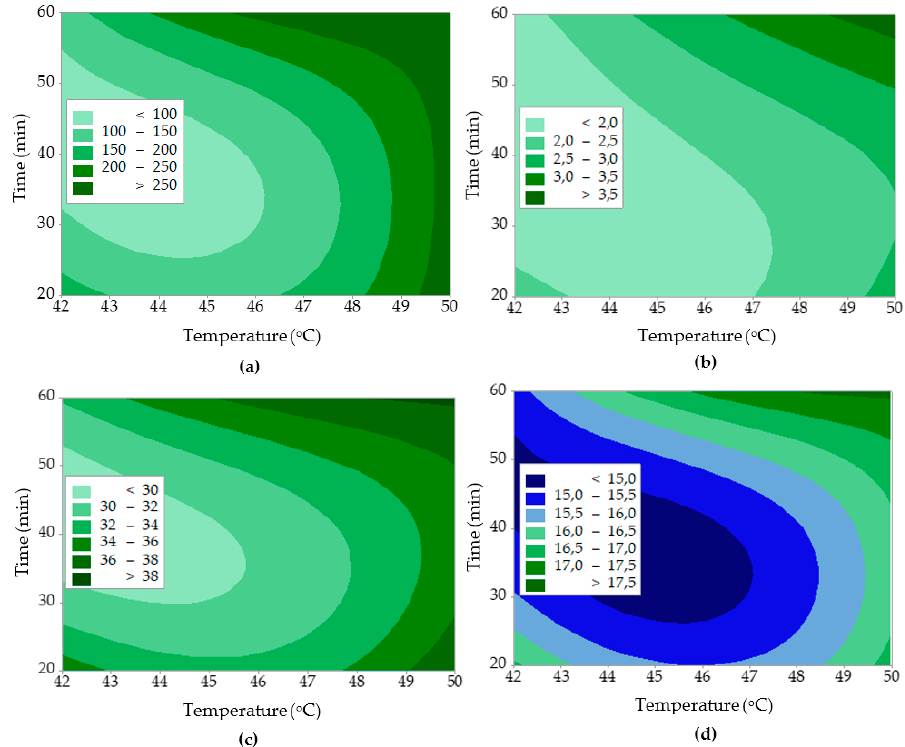
Figure 2 . The influence of extraction temperature and extraction time on second gelatin fractions